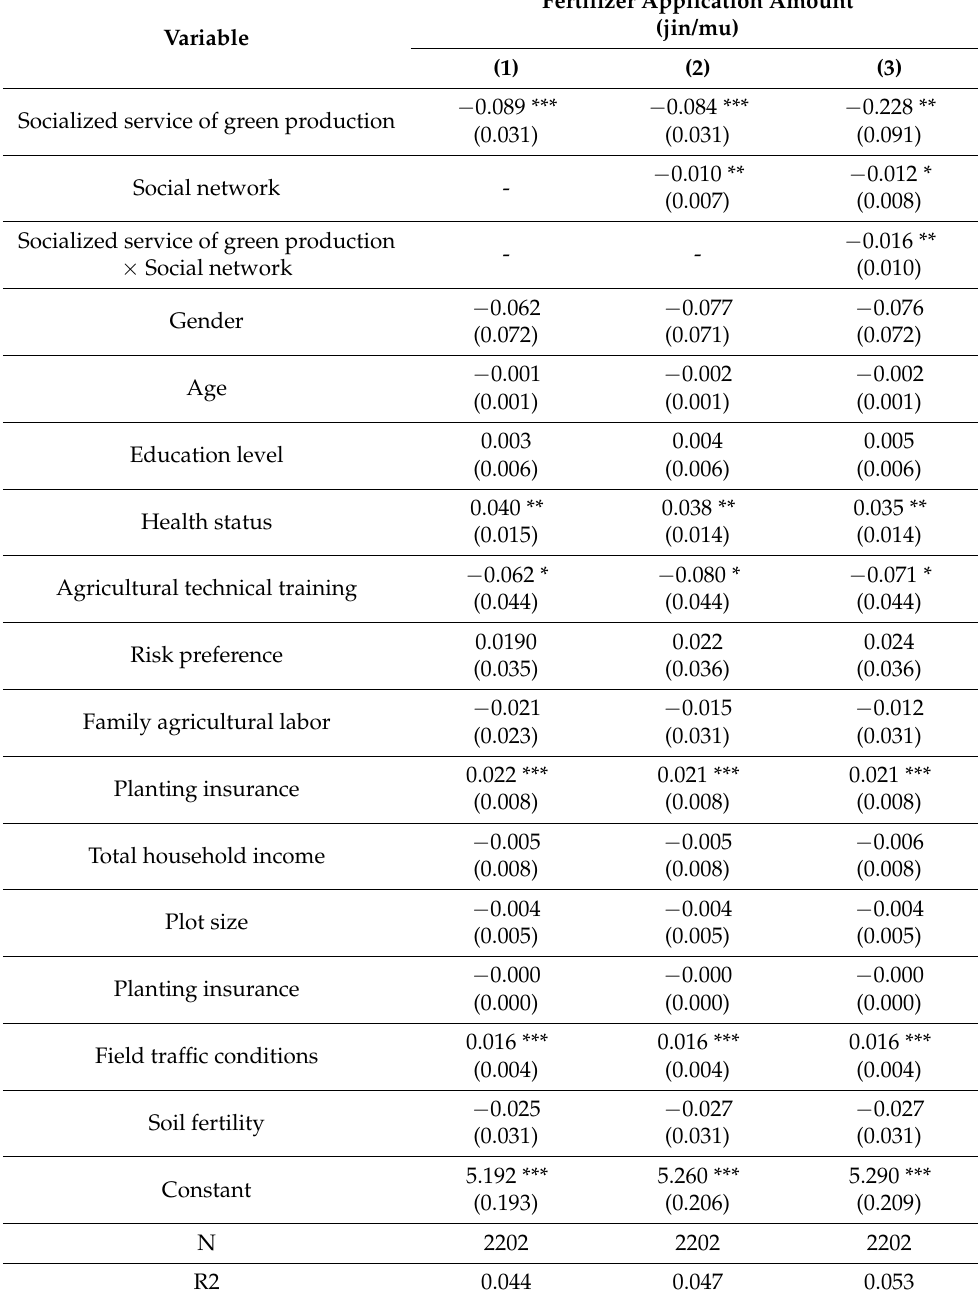
Table 2. Estimated results of the impact of socialized services of agricultural green production and social networks on farmers’ chemical fertilizer